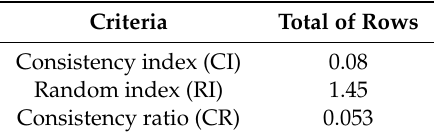
Table 13. Consistency indices.